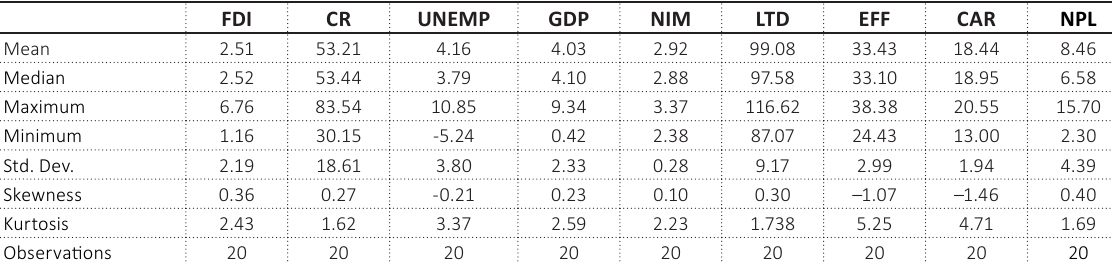
Table 2. Descriptive statistics for the NPL determinants